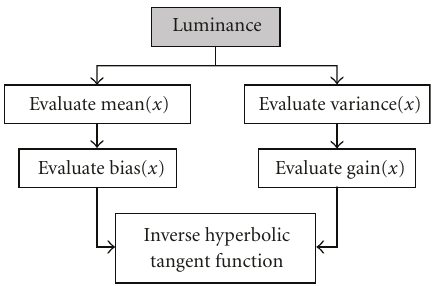
Figure 8: A flowchart of AIHT parameters evaluates.